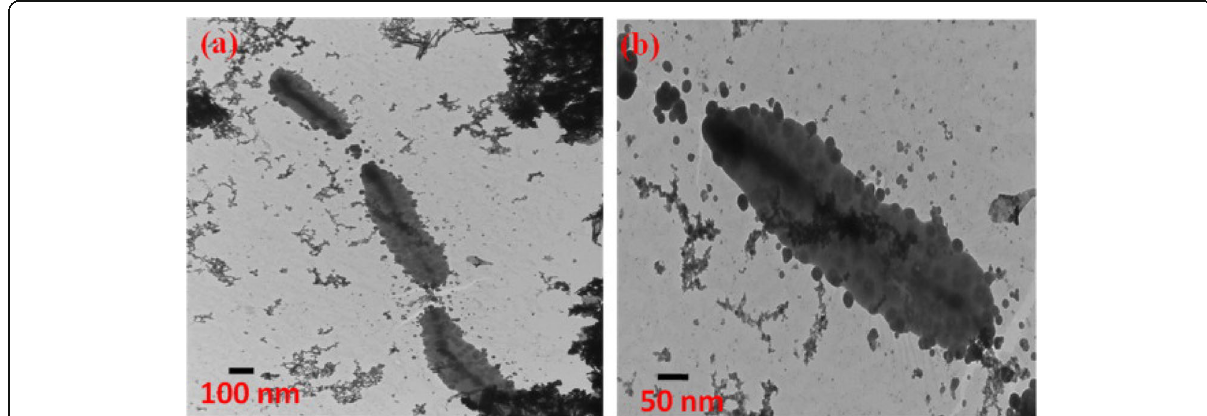
Fig. 9 a TEM images of E. coli mixed with Ag/Fe 2 O 3 /ZnO heterostructure. b Ag/Fe 2 O 3 /ZnO heterostructure anchored on the surface of E. coli . Reproduced from ref. [73] with permission from